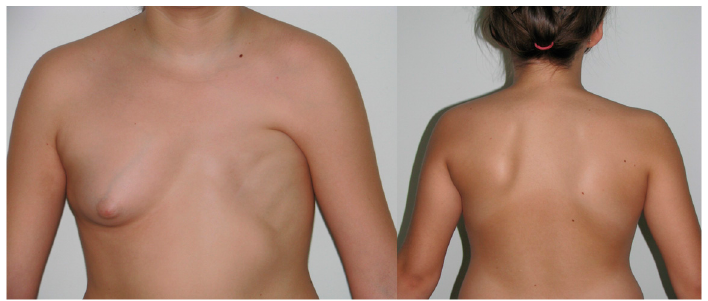
Figure 2. 21-year-old female patient with left-sided Poland syndrome (frontal and back view). Measured parameters were compared for the affected side and the nonaffected side in patients with Poland syndrome. The results are presented in Table 1. The lengths of digits 2 and 4 were significantly higher on the nonaffected side (both p < 0.001). The r-styr parameter was statistically higher on the nonaffected side than on the affected side ( p < 0.001). The mean of 2D:4D ratio was not significantly different between sides ( p = 0.197). The analysis is presented in Figure 3.